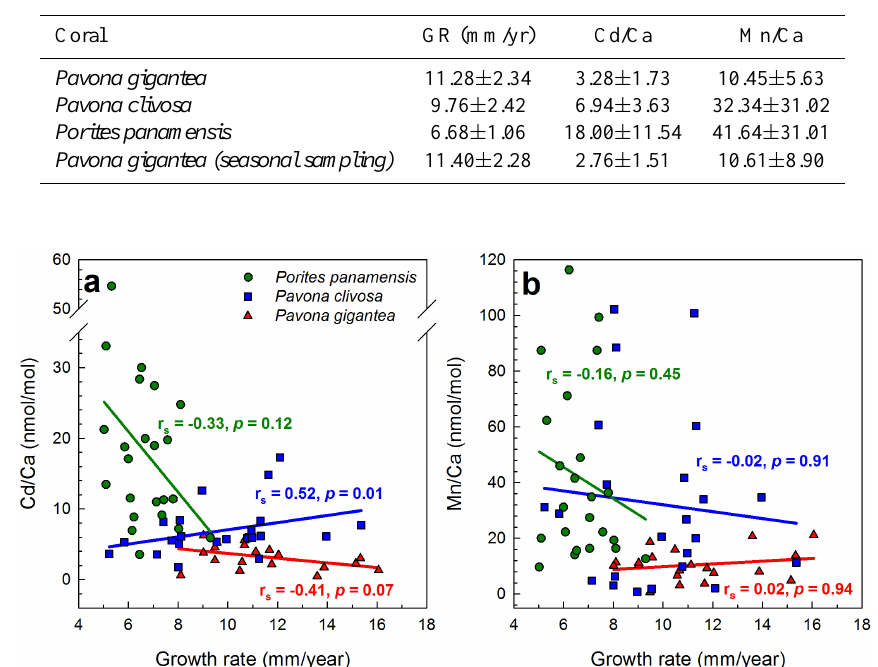
Fig. 4. Relationship between skeletal growth rate and Cd/Ca (a) and Mg/Ca (b) for Porites panamensis , Pavona clivosa and Pavona gigantea . Spearman rank correlation value ( r s ) and statistical probability ( p) are